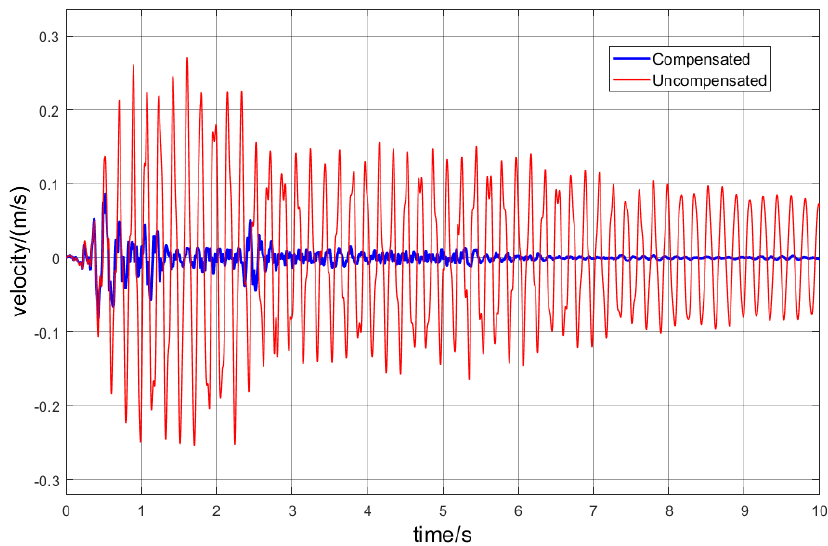
Figure 8. Comparison between the velocity signal of an uncompensated building versus a compensated one with a PSO-tuned BEL